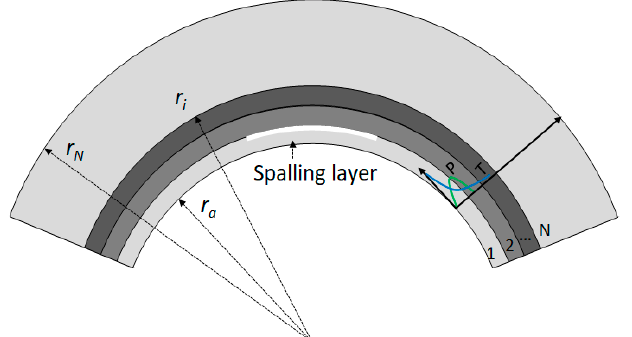
10 of 21 Figure 8. Schematic of the spalling process of concrete lining under tunnel fire. 4. Analytical Prediction of Layered Spalling of Tunnel Lining A multilayer thermoelastic model is proposed to analyze the temperature and stresses of tunnel lining exposed to fire. The following assumptions are adopted to facil ‐ itate the development of the model: (1) the tunnel section is simplified as a circle; (2) concrete is isotropic at the macro level, and the damage caused by temperature is also isotropic at each layer; (3) the temperature distribution on the cross ‐ section is uniform; (4) the material of each layer is assumed to be homogeneous and linearly elastic. As shown in Figure 9, the inner and outer radii of the model are r 0 and r N in the cy ‐ lindrical coordinates. The inner surface is the heated surface. r i is the outer radius of the